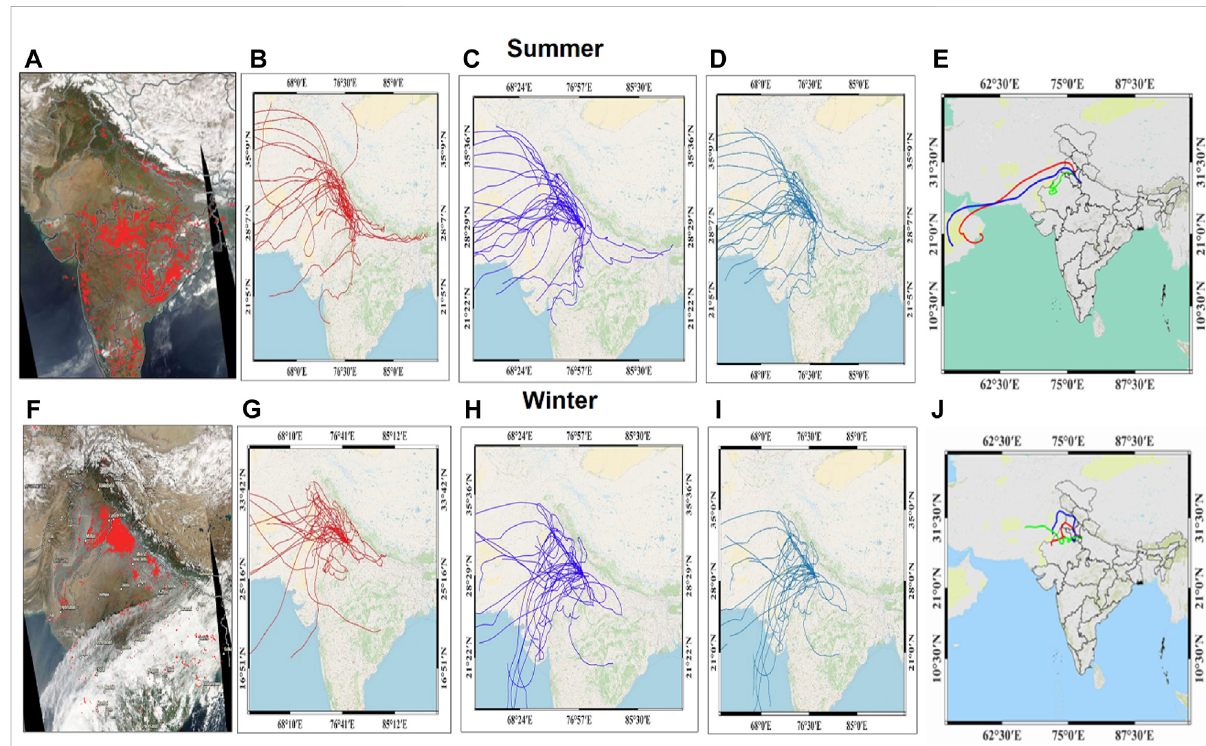
FIGURE 6 Pro fi les of biomass fi re points and trajectory paths during summer (A – E) and winter (F – J) . (A) and (F) : Geographical locations of fi re points relatedto biomassburning. (B) and (G) :Trajectory pathsat500 mheight. (C) and (H) :Trajectory pathsat1,000 mheight. (D) and (I) :Trajectory paths at 1,500 m height. (E) and (J) : Representative trajectories at heights of 500, 1,000, and 1,500